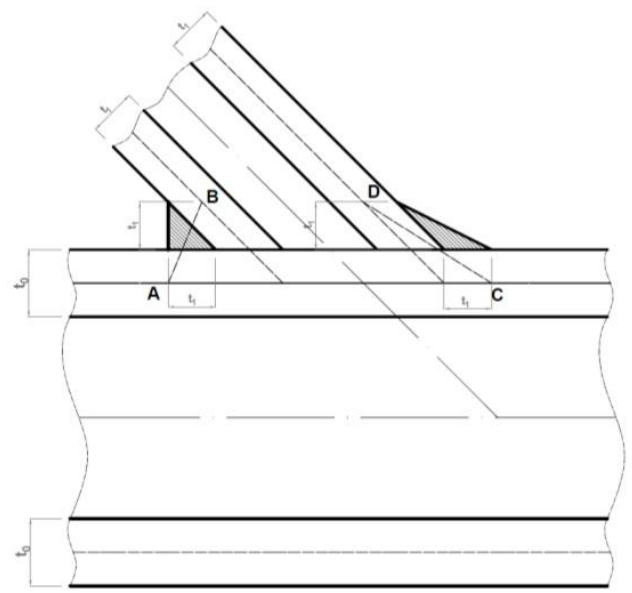
Figure 1. Weld geometry modeling with shell elements (A–B and C–D).